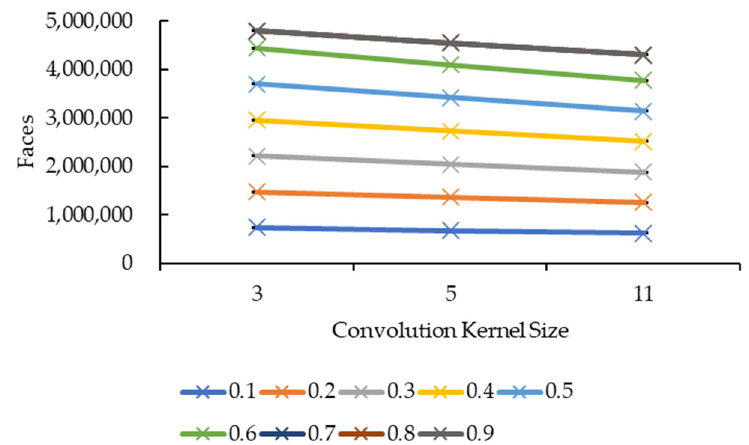
Figure 17. Graph of number of faces against convolution kernel size.